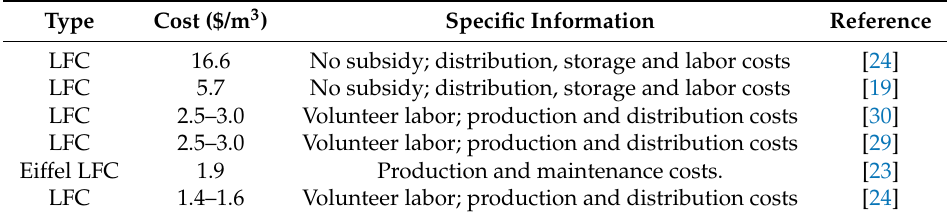
Table 1. Cost of producing a cubic meter of water from fog collection ($ per m 3 ) using Large Fog Collectors